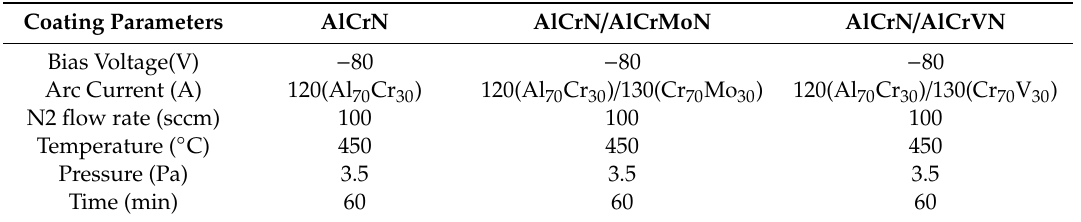
Table 1. Deposition parameters of the coatings by physical vapor deposition (PVD) process. Coating